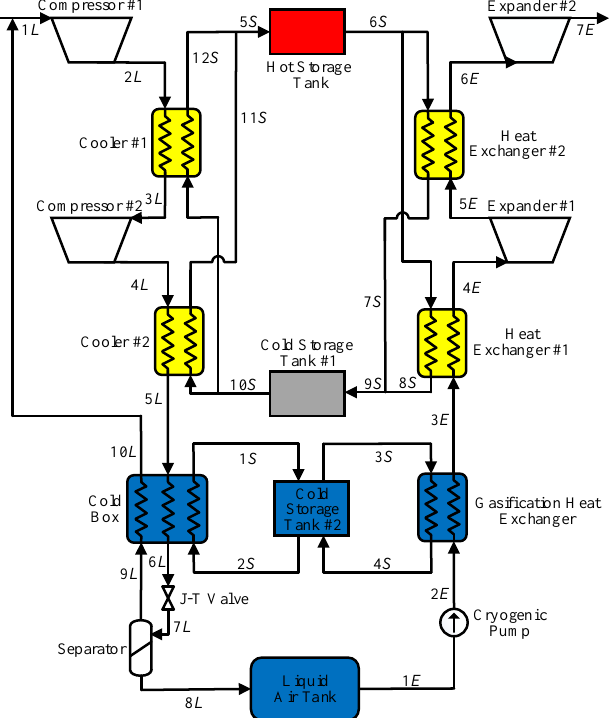
Figure 1. Schematic diagram of an integrated liquid air energy storage and electricity generation system.